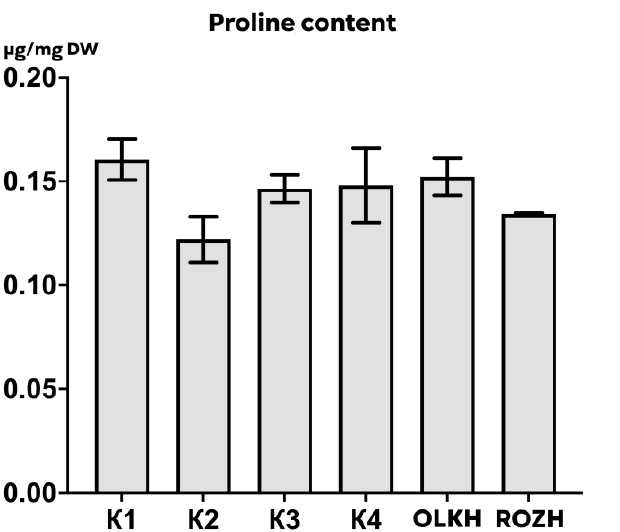
Figure 8. Proline concentration in tubers of H. tuberosus growing in contaminated areas and in areas without contamination.